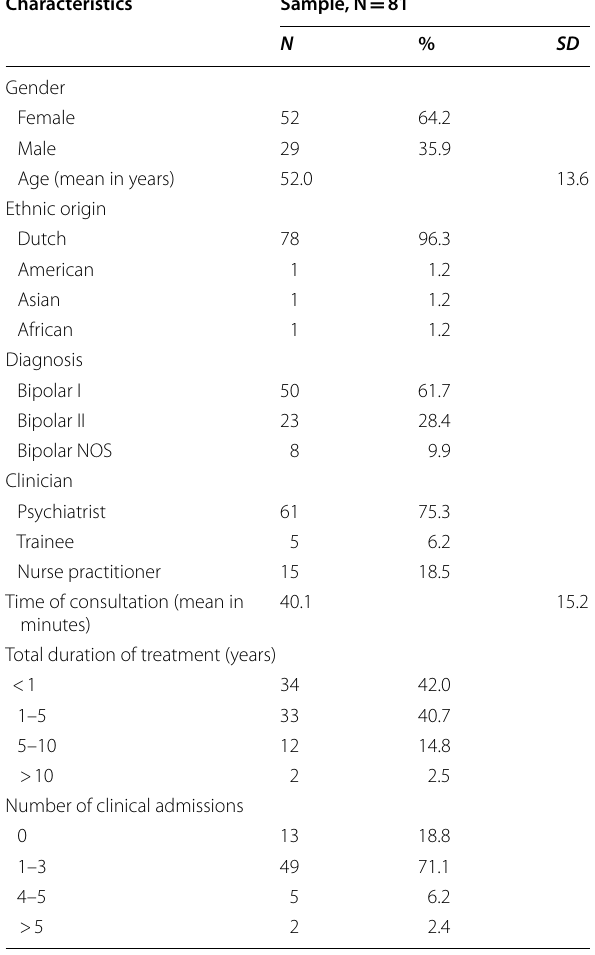
Table 1 Patient